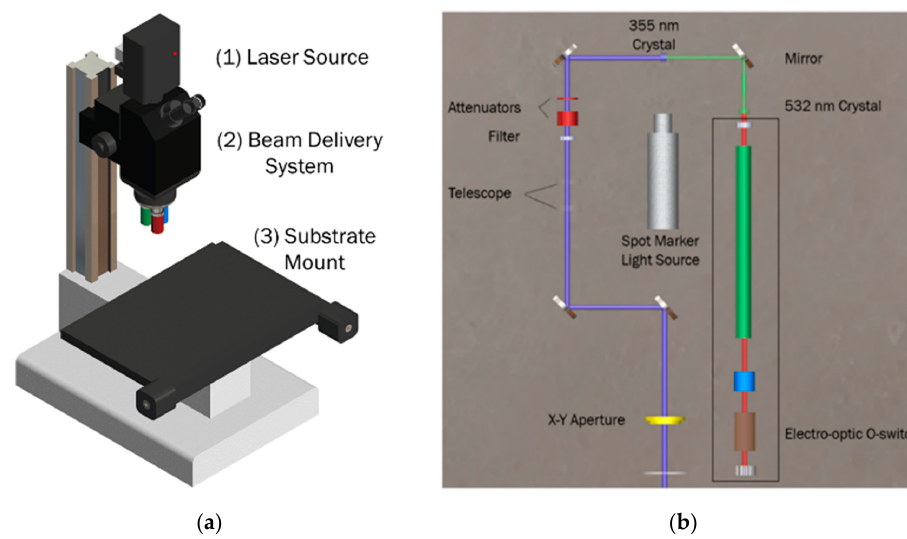
Figure 3. ( a ) External schematic of a QuikLaze 50ST2 Multimodal Laser Micromachining System. The three components of every laser micromachining system are shown: (1) the laser source box; (2) the beam delivery system; and (3) the motorized substrate mount. ( b ) Internal schematics of the laser source box. This shows the three crystals and a switch that create the different wavelengths of light the system produces with the ability to switch between three wavelengths.